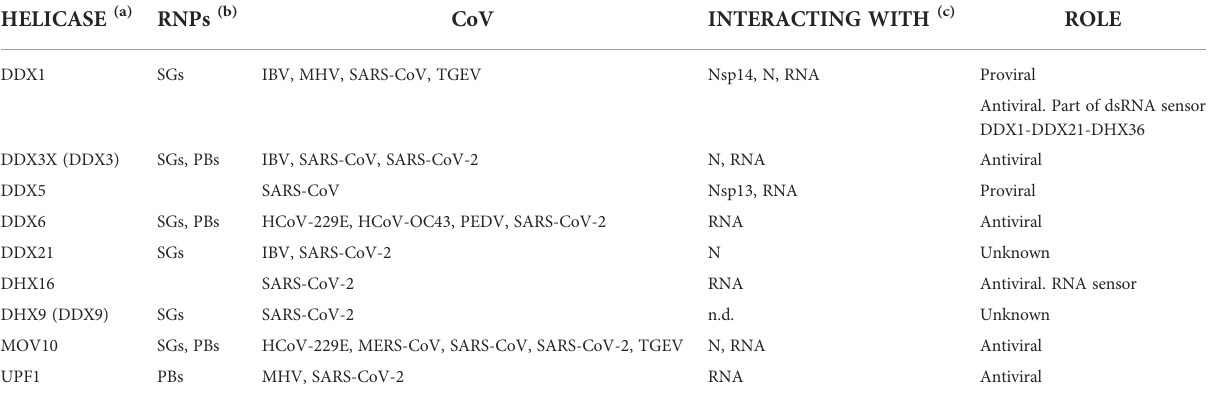
TABLE 1 RNA helicases involved in CoV